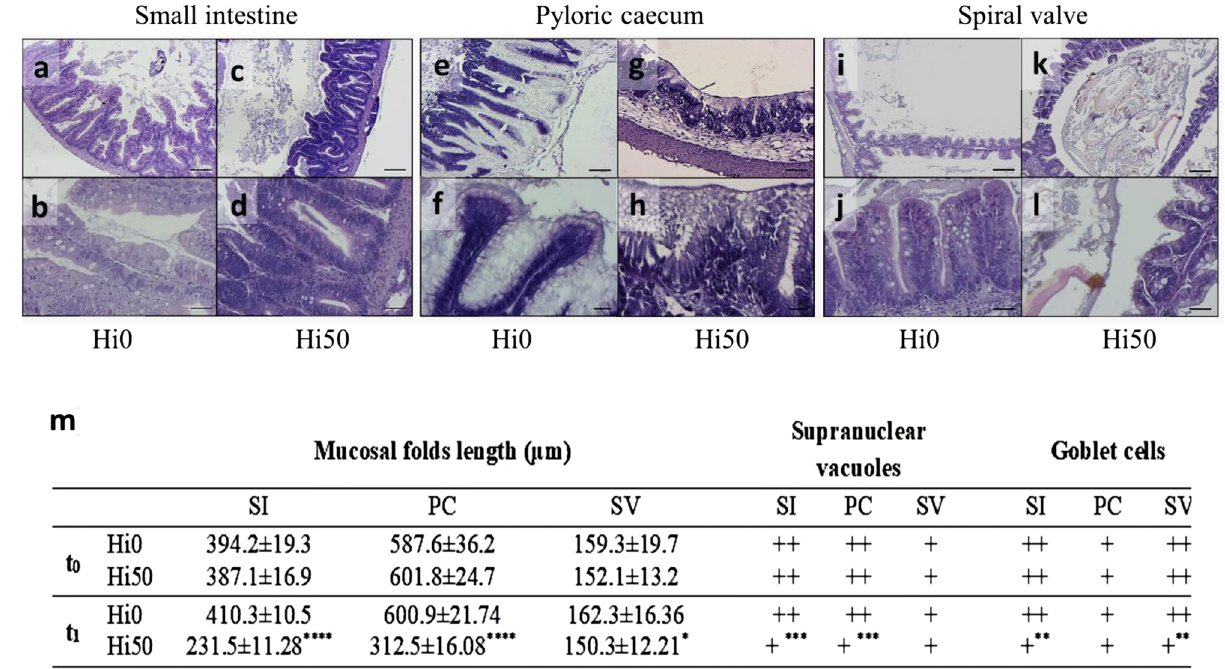
Figure 4. Siberian sturgeon’ small intestine (SI), pyloric caeca (PC) and spiral valve (SV) histology at t 1 and histological indexes (mucosal folds length, supranuclear vacuoles abundance and goblet cells number) calculated in these gut tracts. ( a – d ) small intestine; ( e – h ) pyloric caecum; ( i – l ) spiral valve. Histology scale bars: ( a , c , e , g ) 100 μm; ( b , d , f , h , j , l ) 50 μm; ( i , k ) 200 μm. For histological indexes ( m ), values are showed as mean ± SD (n = 15). Scores: supranuclear vacuoles + scattered, ++ abundant; goblet cells + 0 to 4 per villus, ++ more than 4 per villus. Significant differences, calculated within the same sampling time, between Hi0 and Hi50 are indicated as follows: ns, non-significant; *p < 0.05; **p < 0.01; ***p < 0.001 and ****p < 0.0001. Sturgeon fed diets including 0 and 50 of BSF meal (Hi0 and Hi50,